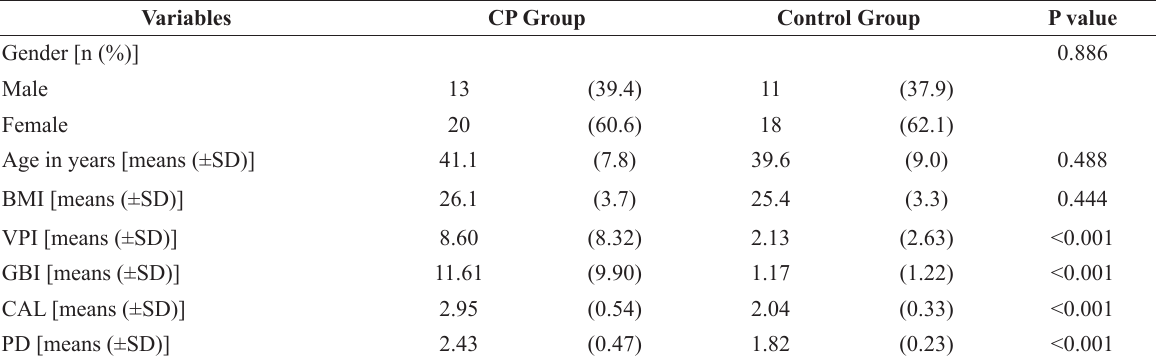
General characteristics and periodontal markers in baseline between study groups.